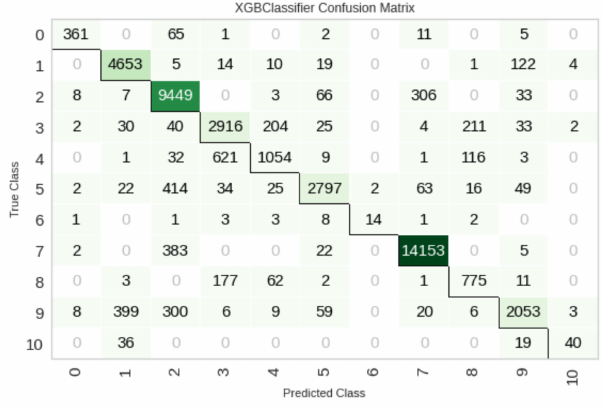
Figure 4. Confusion matrix of the XGBoost classifier.